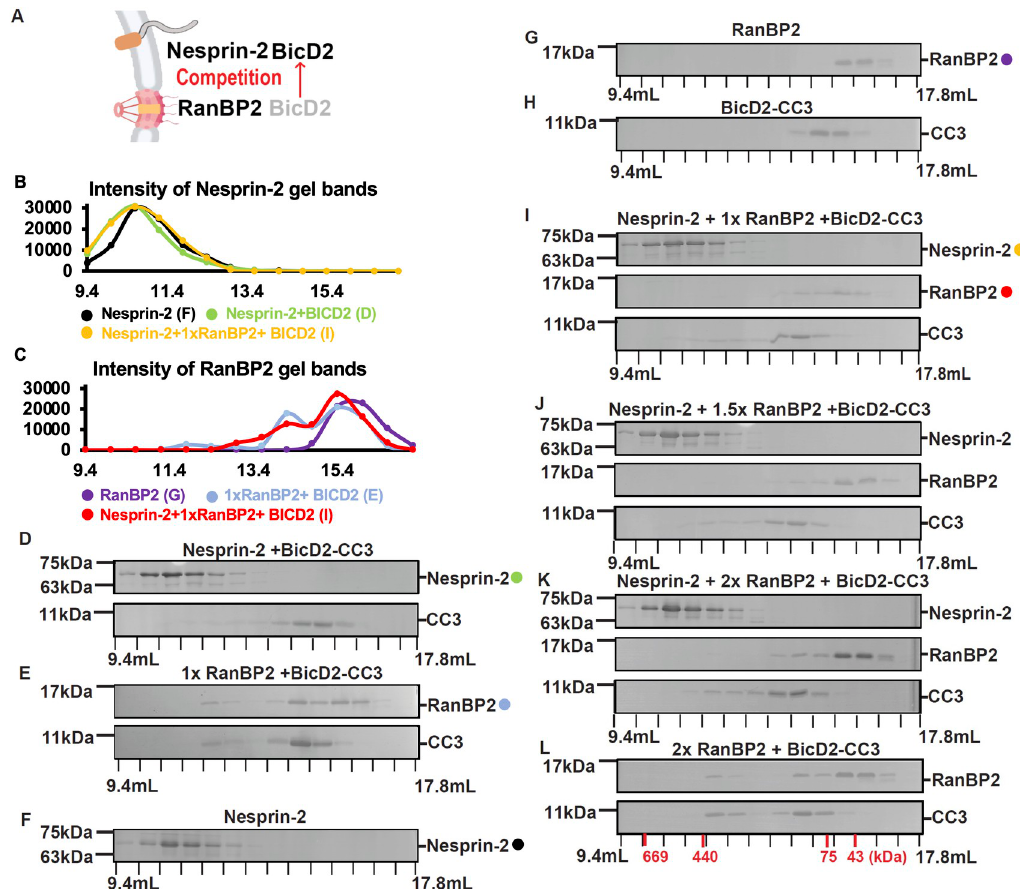
Fig 2. Nesprin-2 competes with RanBP2 for BICD2-CC3 binding. (A) Schematic representation of the assay. (B-L) A purified RanBP2 fragment (aa 2148–2240) and/or Nesprin-2 fragment (for sequence see S1A Fig) plus BICD2-CC3 (residues 711–800) were mixed at a 1:1:1 molar ratio and analyzed for physical interactions by size exclusion chromatography. SDS-PAGE analysis of the elution fractions (D-L) and (B,C) intensity profiles of the gel bands are shown. (B) Intensity profiles of Nesprin-2 gel bands from the SDS-PAGEs shown in panels D, F and I (see color-coded circles). (C) Intensity profiles of RanBP2 gel bands from the SDS-PAGEs shown in panels E, G and I (see color-coded circles). (D-L) SDS-PAGE of elution fractions for: (D) Nesprin-2 and BICD2-CC3 (E) RanBP2 and BICD2-CC3. (F, G, H) As controls, the individual proteins were also analyzed: (F) Nesprin-2; (G) RanBP2; (H) BICD2-CC3. (I, J, K) Nesprin-2, RanBP2 and BICD2-CC3 were mixed in 1:1:1 molar ratio, in 1:1.5:1 molar ratio and 1:2:1 molar ratio with increasing amounts of RanBP2. (L) As a control for (K), RanBP2 and BICD2-CC3 were mixed at a 2:1 molar ratio. For all gels, the masses of molecular weight standards are indicated at left and elution volumes at the bottom. All experiments were repeated at least twice. The elution volumes of molar mass standards are indicated in red at the bottom of panel